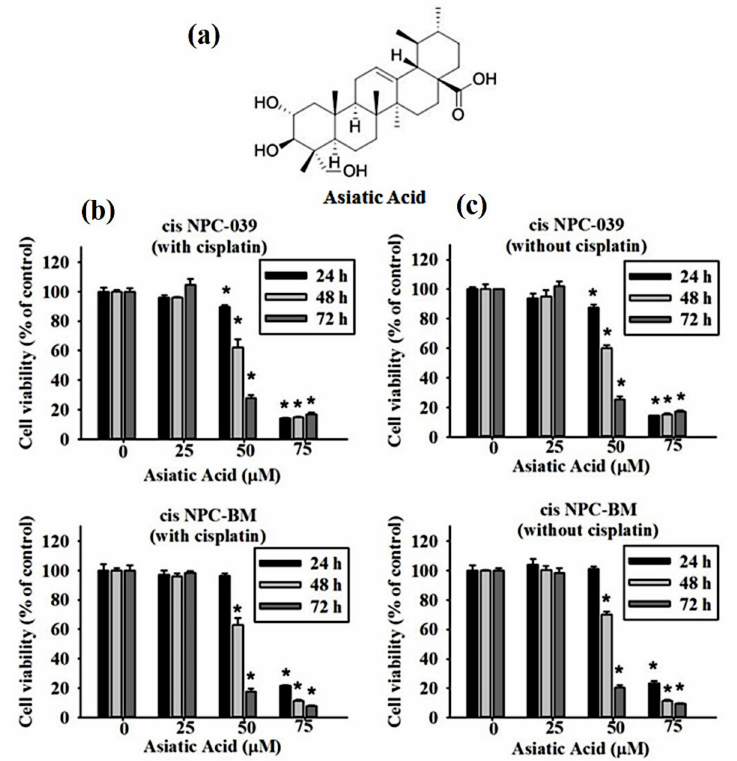
Figure 1. Cytotoxic e ff ects of Asiatic acid on cisplatin-resistant human NPC cell lines (NPC-039 and NPC-BM) ( a ) The chemical structure of Asiatic acid. ( b ) The cell viability significantly decreased in AA-treated cis NPC-BM cell and cis NPC-039 cell with cisplatin and ( c ) without cisplatin in a dose and time dependent manner under MTT assay. * p < 0.05 as compared with control